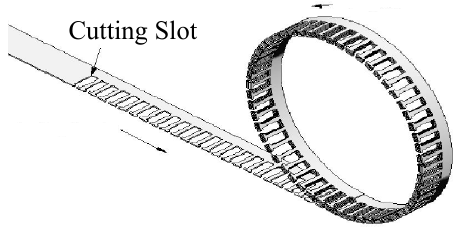
Figure 5. Scheme of rolled lamination [31].